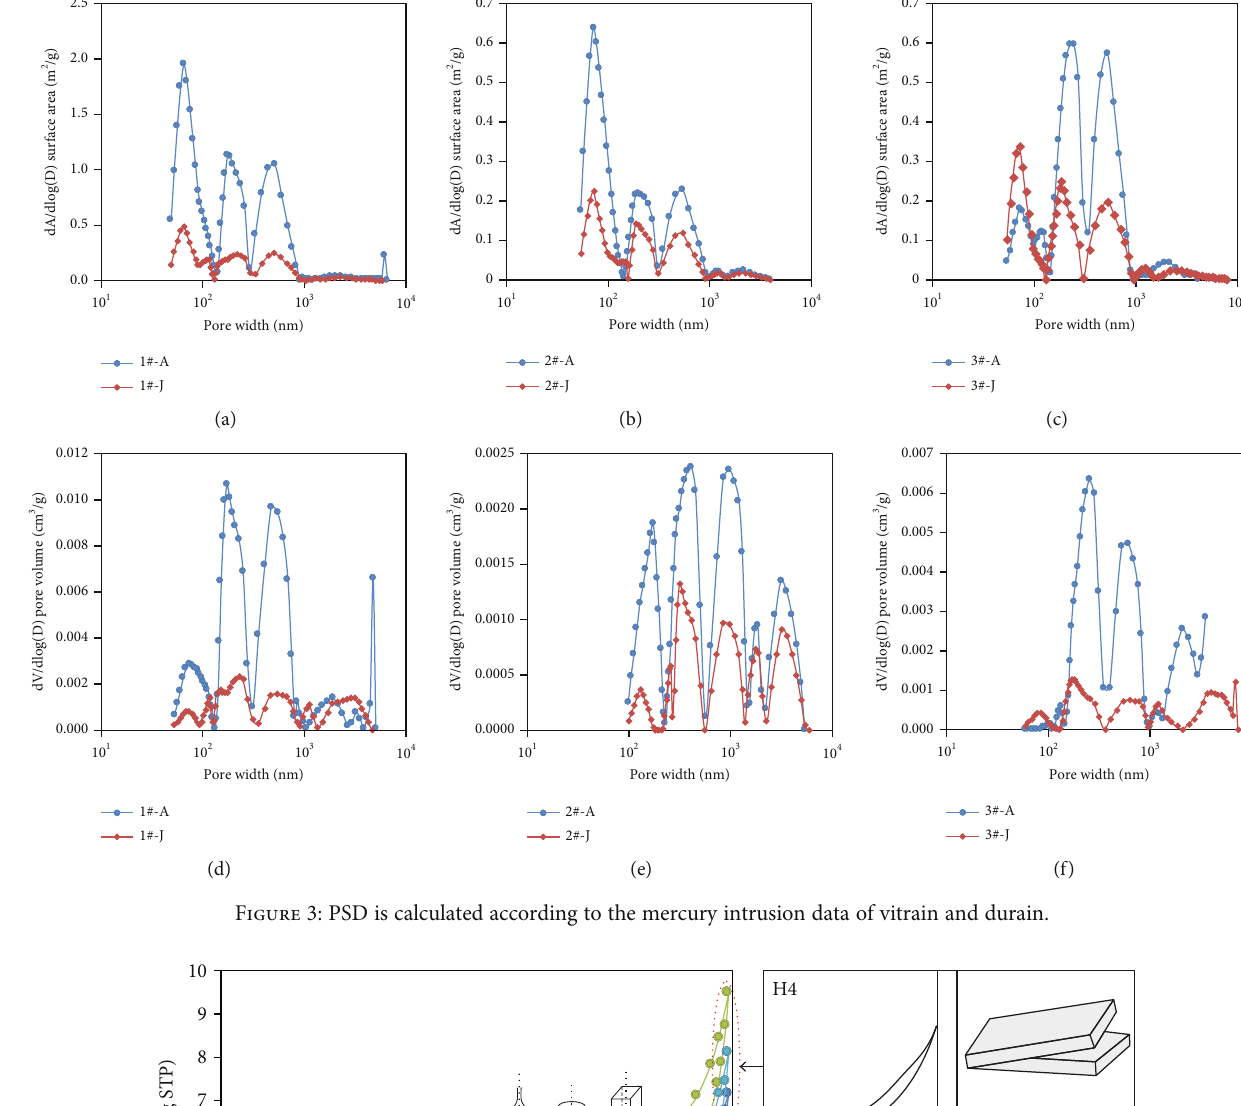
Figure 3: PSD is calculated according to the mercury intrusion data of vitrain and durain.